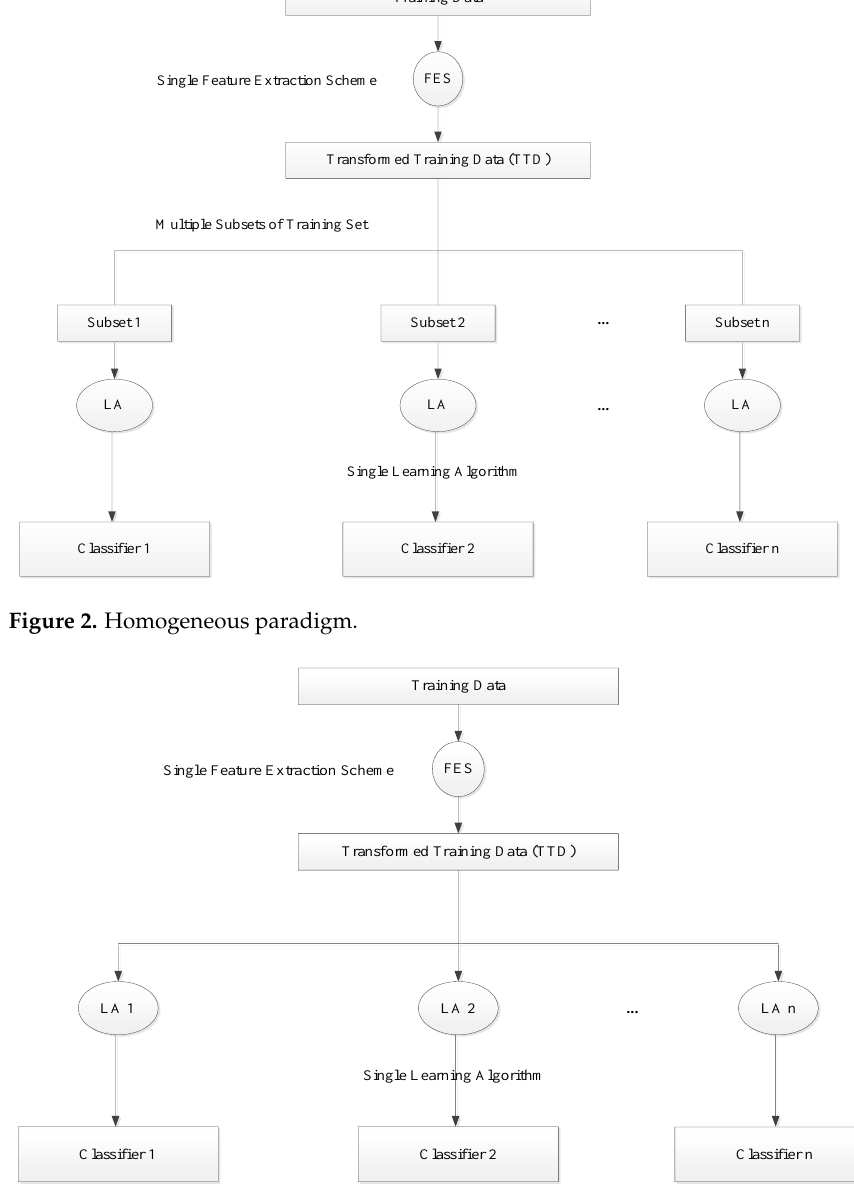
Figure 3. Heterogeneous paradigm.